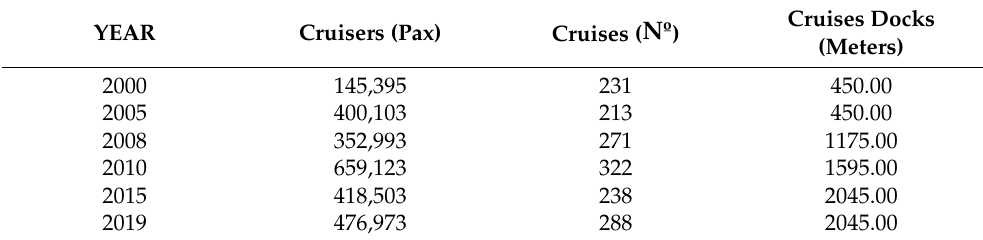
Table 5. Evolution of the infrastructure destined for cruise traffic, as well as number of cruise ships and cruise passengers in Malaga. Table 2. Port data set to determine YEAR Cruisers (Pax) Cruises (